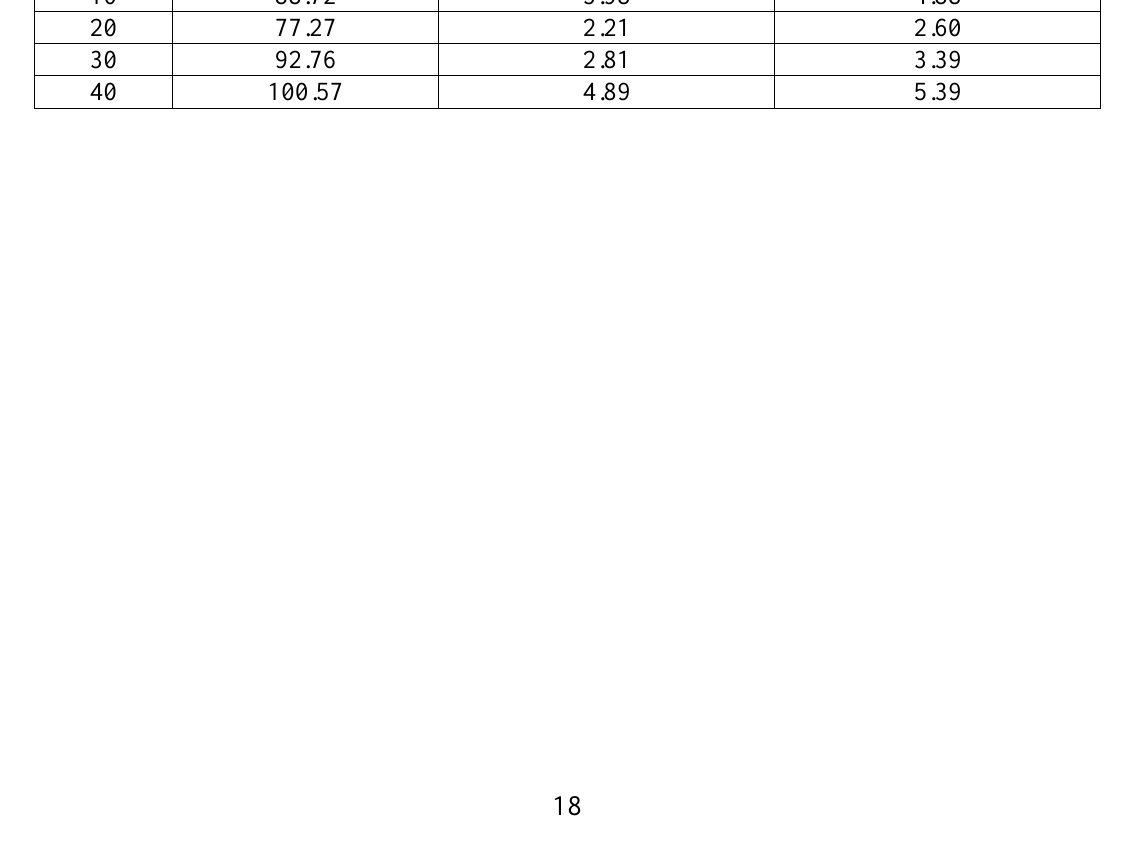
Table 3: Morphology parameters for WO with annealing temperature at T